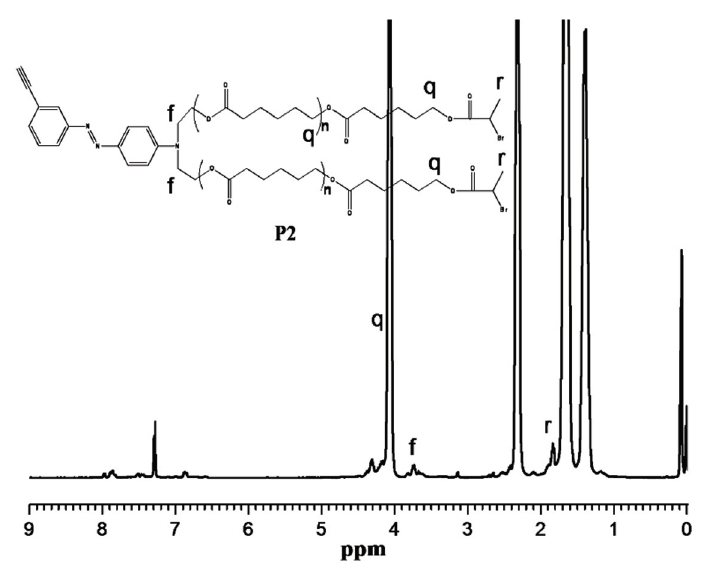
Figure 5. 1 H NMR spectrum of the poly( ε -caprolactone) (P2).